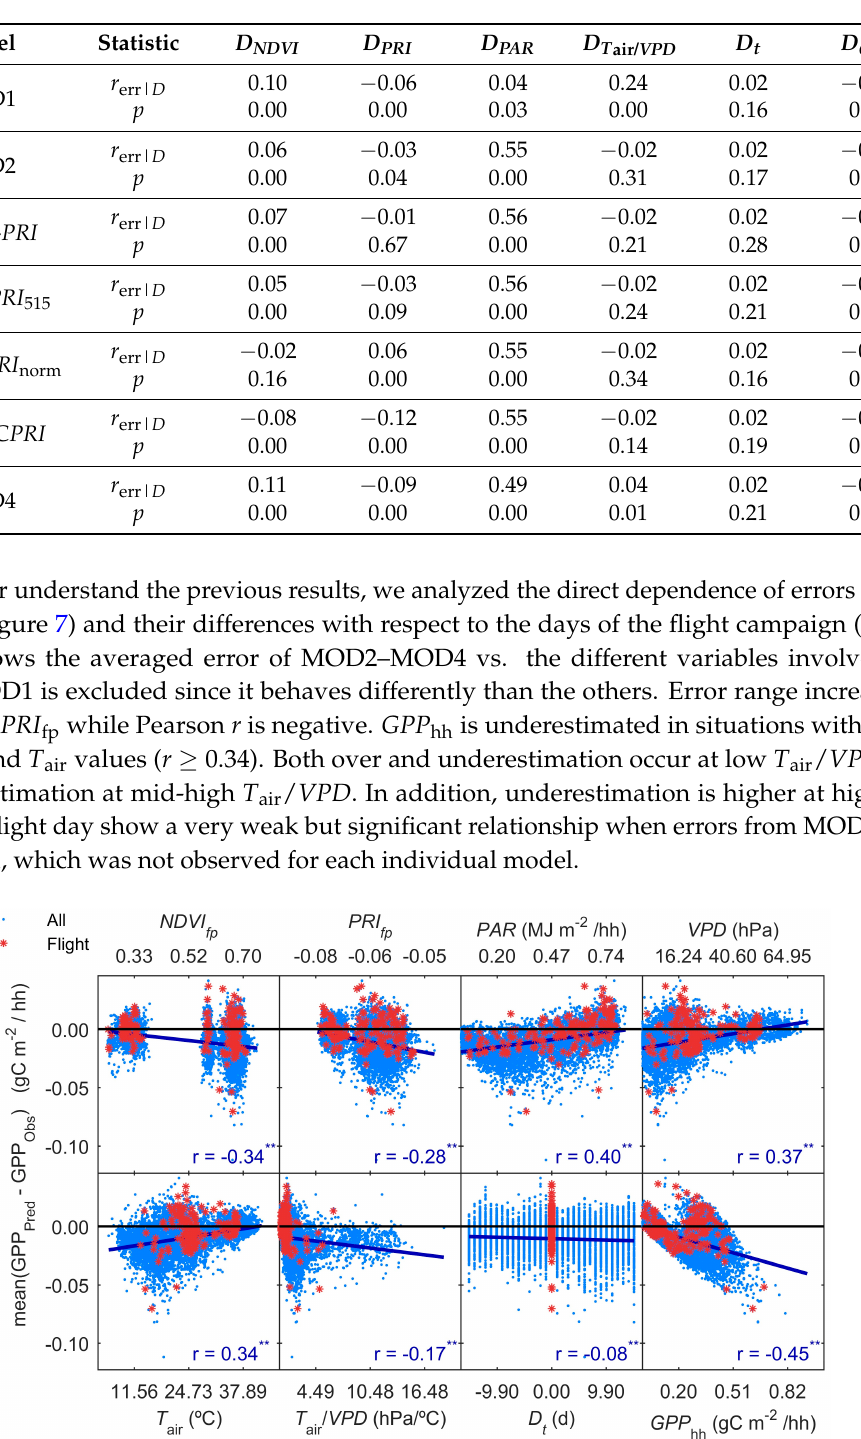
hh prediction errors and the